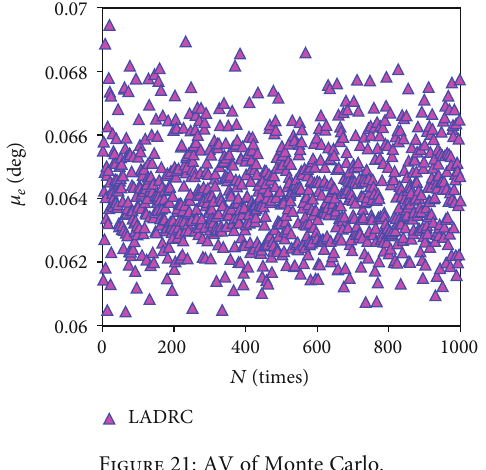
Figure 24: ACC of Monte Carlo.